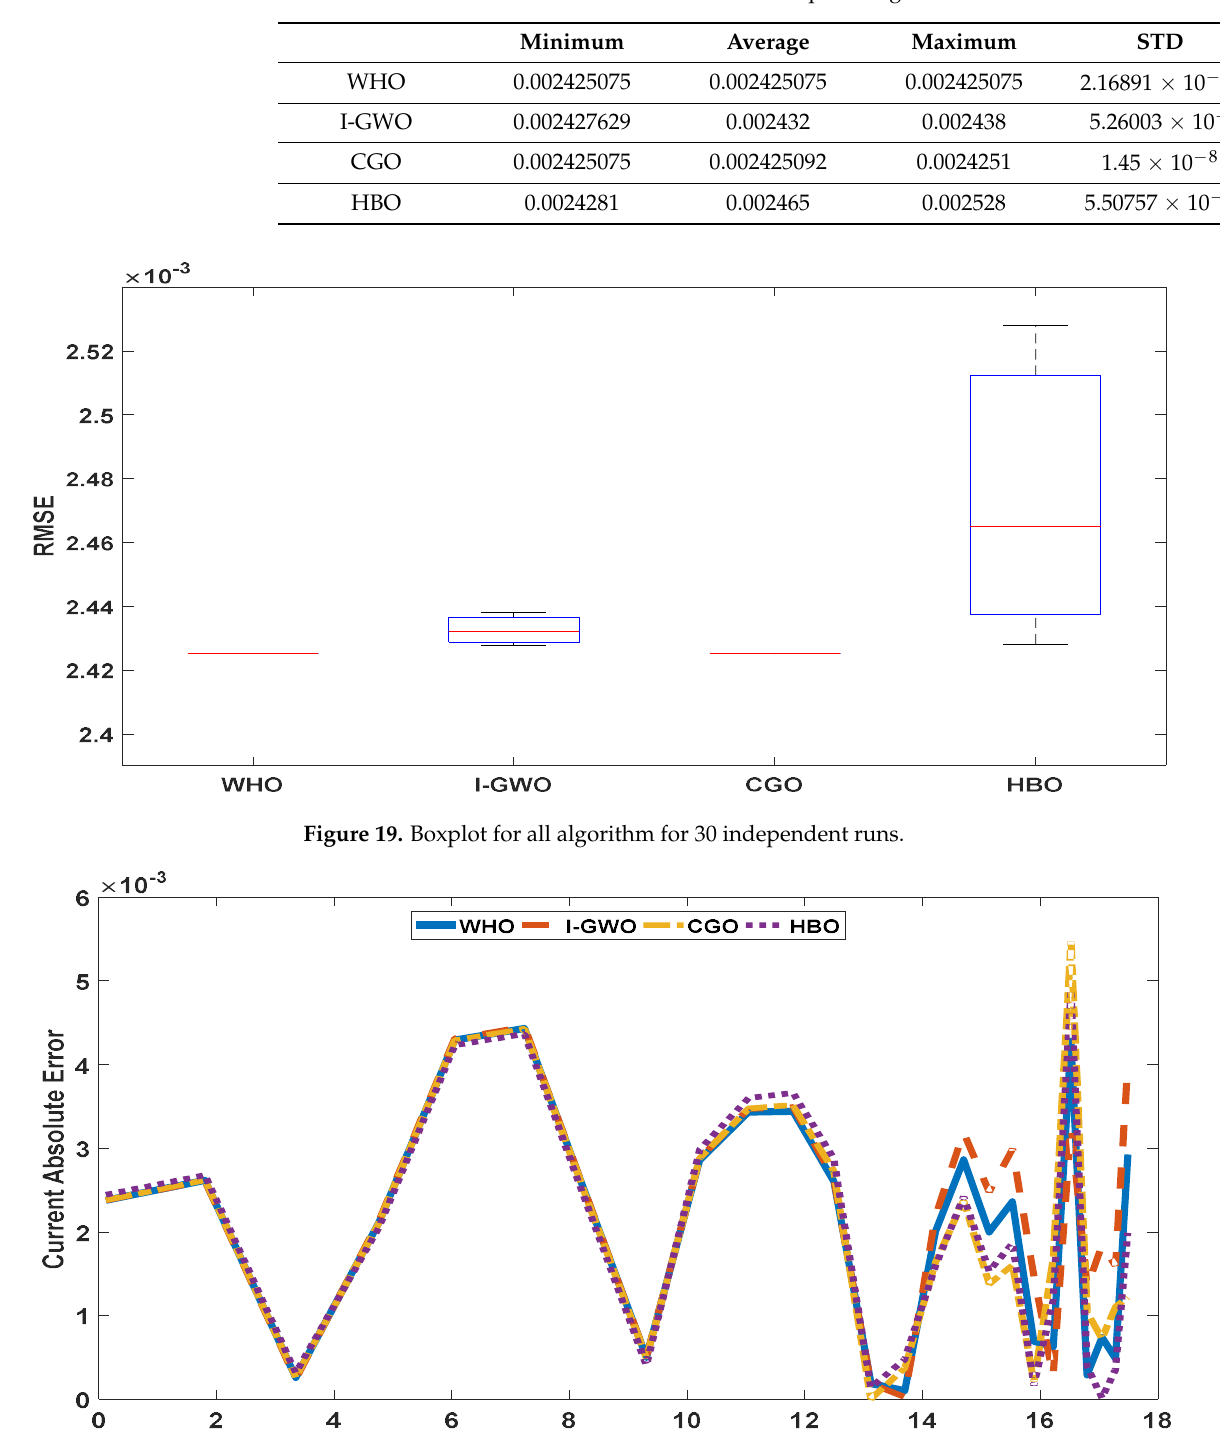
Table 6. The statistical results of WHO and other compared algorithms.